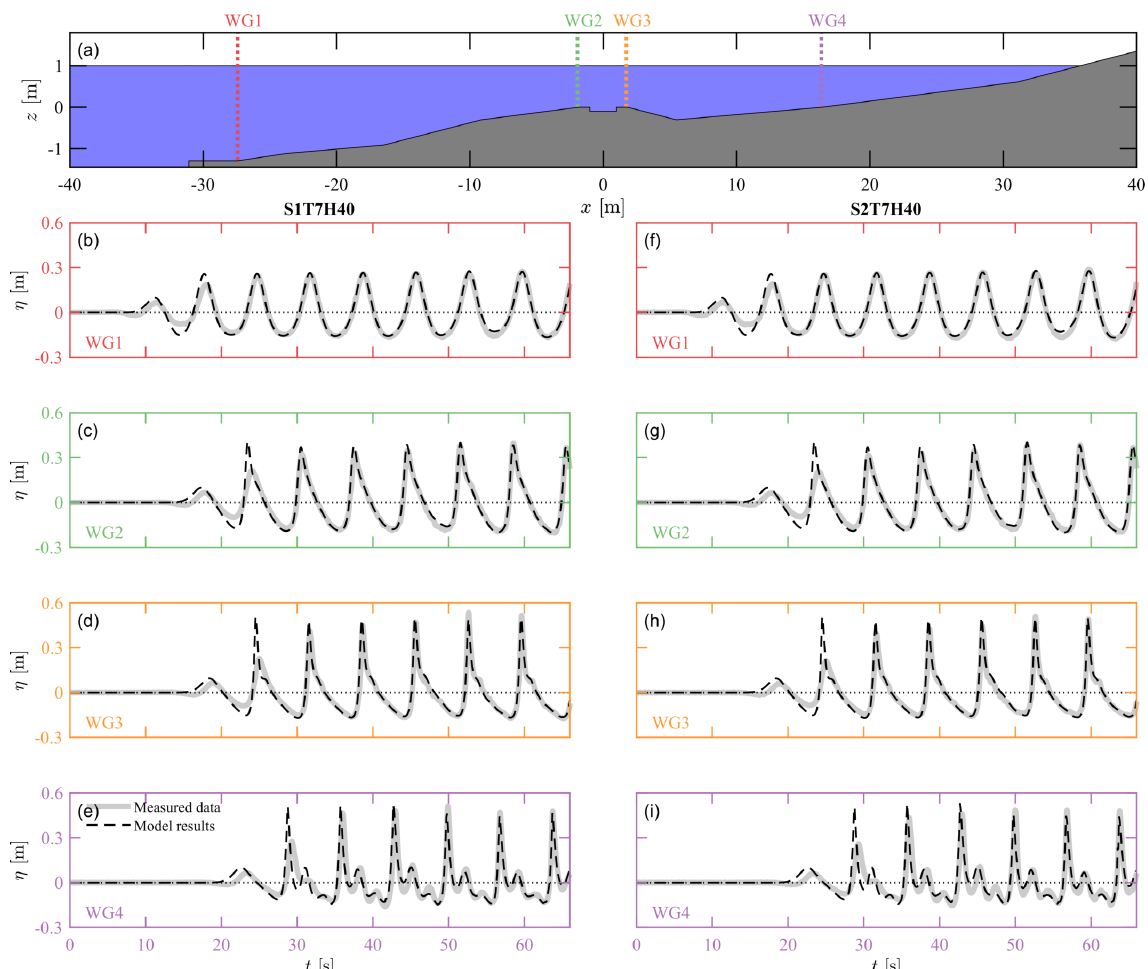
Figure 3. ( a ) A schematic of wave gauge locations in the wave flume, and measured (gray solid curves) and modeled (black dashed curves) free surface elevation, η ( x , t ) , for ( b – e ) S1T7H40 and ( f – i ) S2T7H40 at ( b , f ) x = − 27.41 m, ( c , g ) x = − 1.93 m, ( d , h ) x = 1.73 m, and ( e , i ) x = 16.37 m, as indicated by the color-coded vertical dotted lines in panel ( a